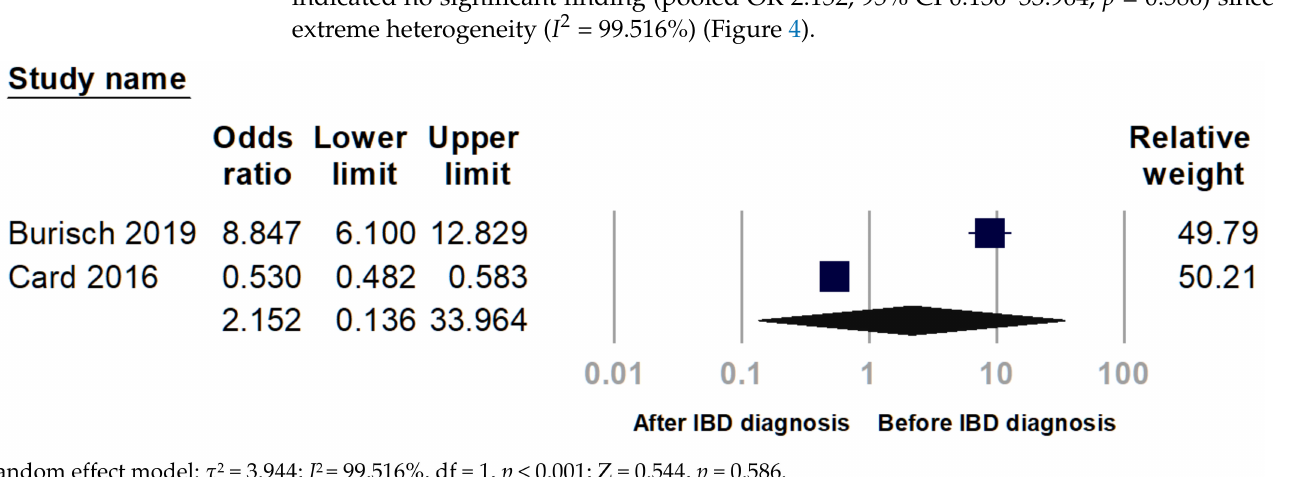
Figure 4. Forest plot for the chronological relationship between uveitis and inflammatory bowel disease